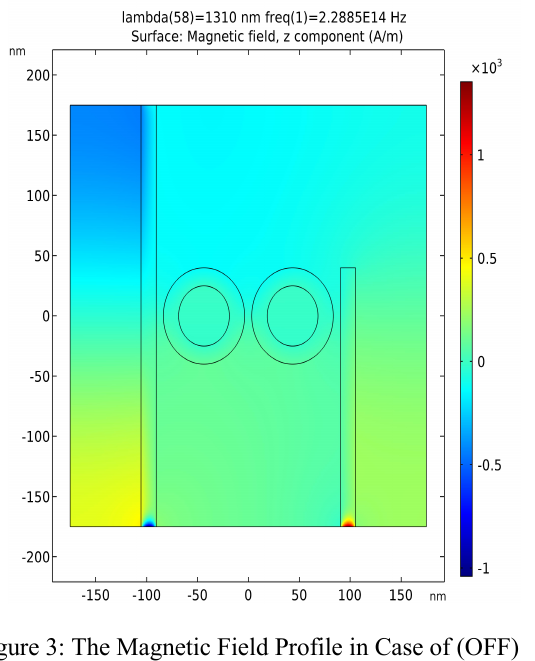
Figure 3: The Magnetic Field Profile in Case of (OFF) Output State.